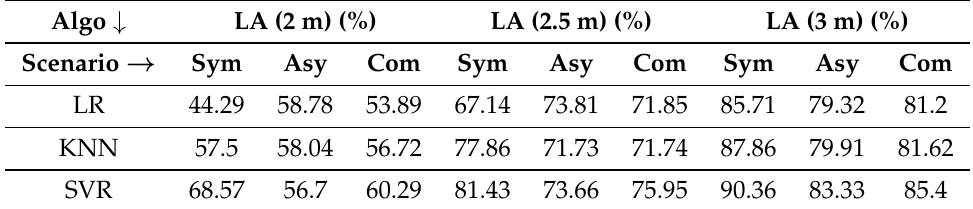
Table 8. LA analysis with different d max values for three scenarios.